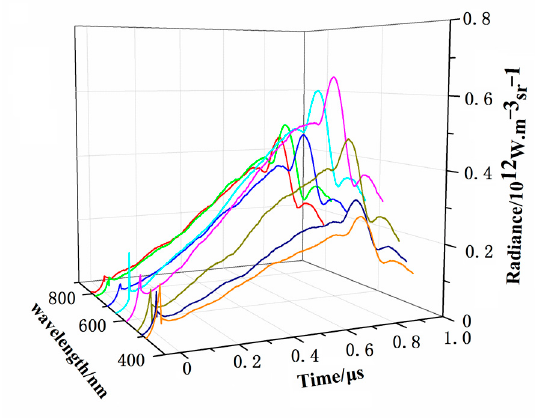
Figure 4. Radiation intensity curve of sapphire.